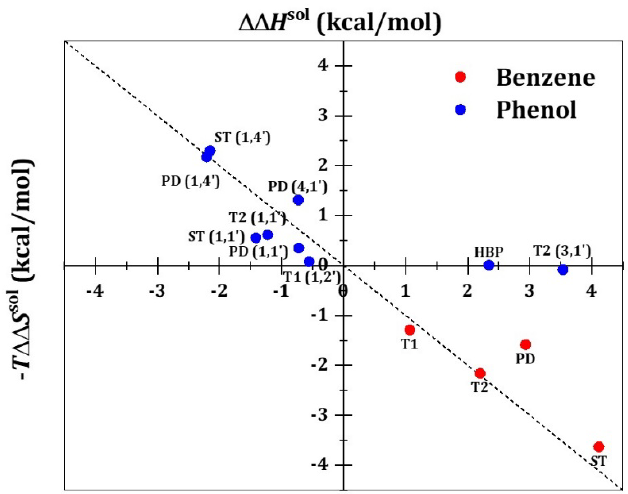
Figure 5. Enthalpic ( ∆∆ H sol ) and entropic contributions ( − T ∆∆ S sol ) of the solvation free energy difference ( ∆∆ G sol ) between a dimer and two monomers. The dashed line represents y = − x . Except for the two outliers, T2 (3,1 (cid:48) ) and HBP phenol dimers, the Benzene and phenol are analogs of phenylalanine (Phe) and tyro sine (Tyr) side